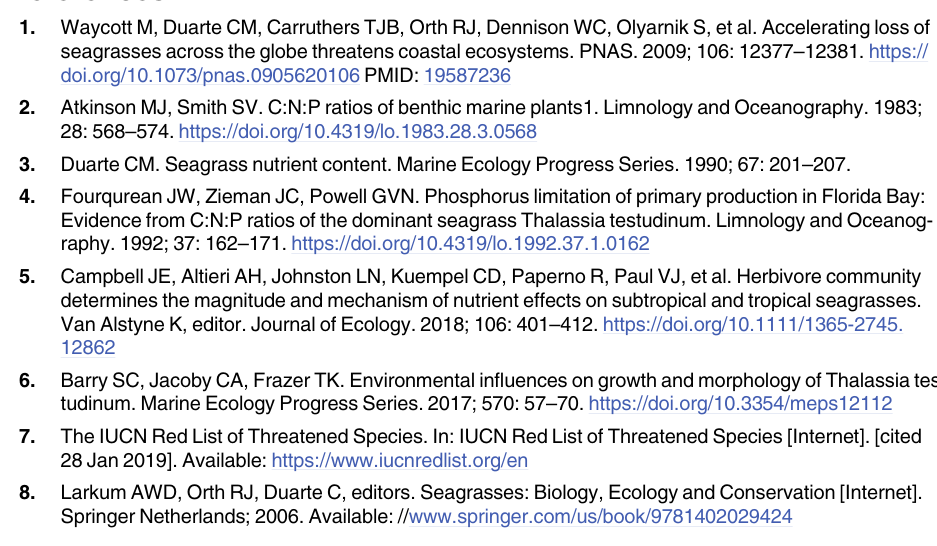
S5 Table. Table of all annotated lipids (confirmed by LipidMatch Flow using MS/MS rule based annotation) with corresponding peak areas, fold changes, and p-values across groups as well as a list of acronyms of